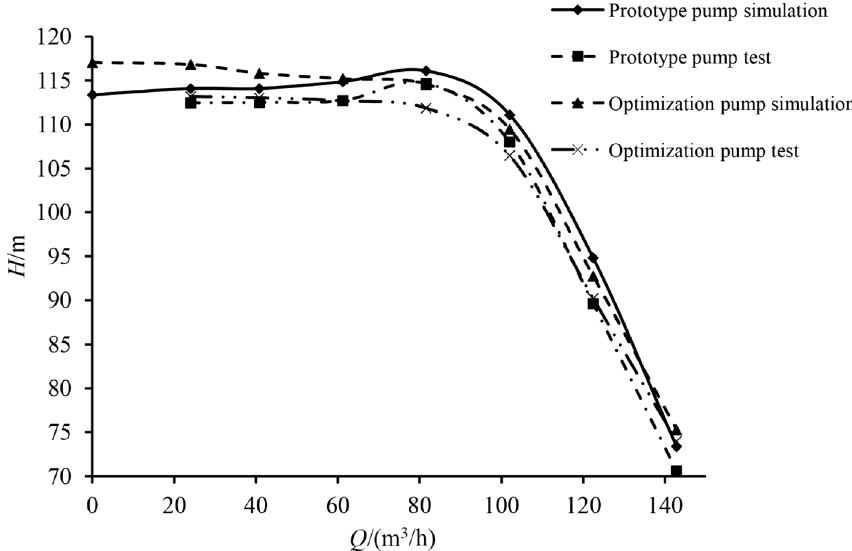
Figure 7. Head curve.